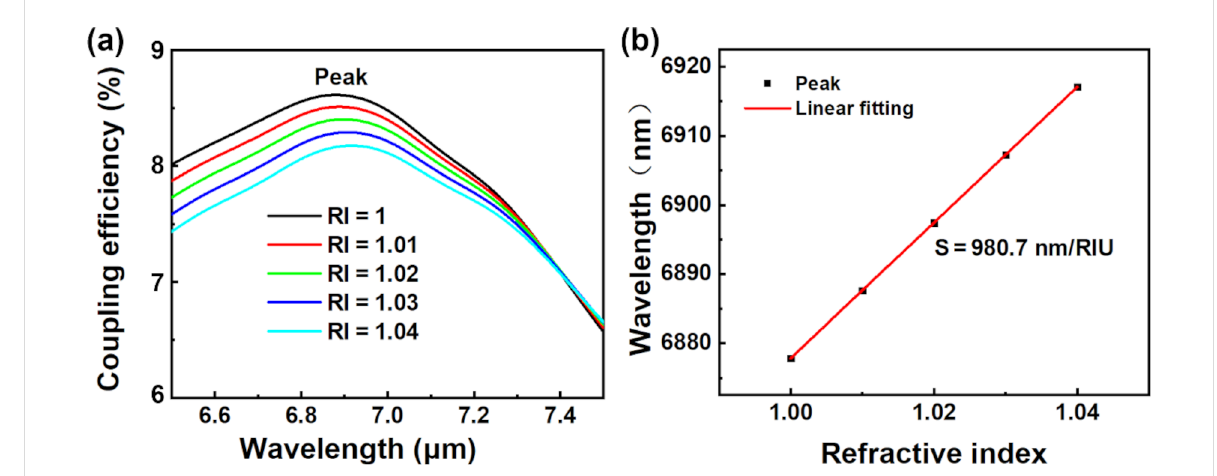
also simulated when it was used as a sensor. The RI sensitivity of the sensor was 980.7 nm/RIU. Therefore, the proposed MIR FGC would provide a potential platform for MIR photonic inte- gration and photonic biosensors detection based on